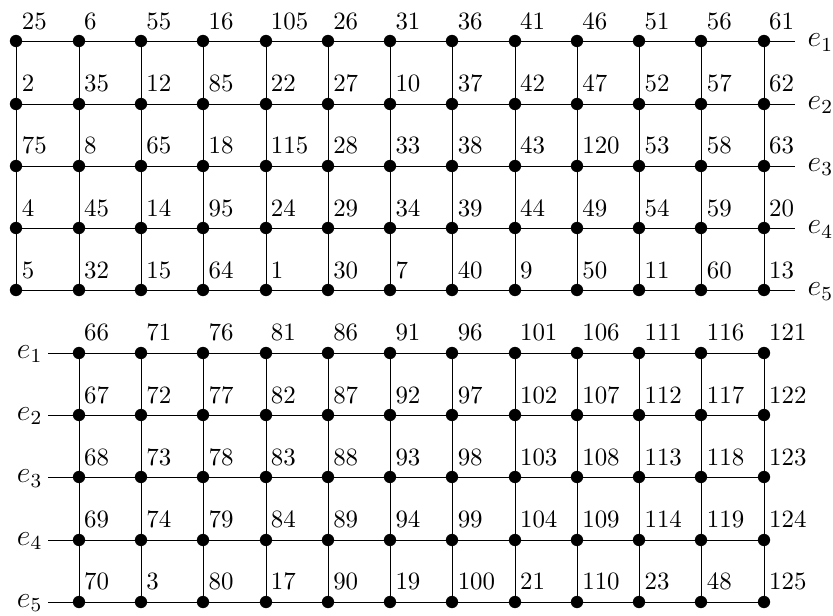
Figure 5: Prime labeling on P